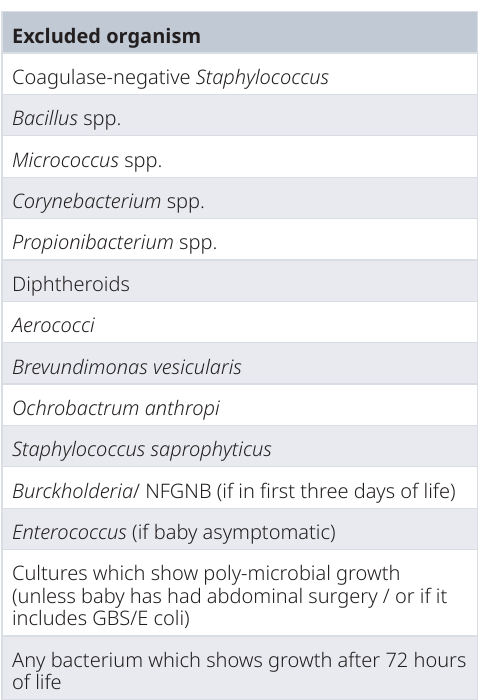
Table 6. Selected organisms considered possible contaminants or skin commensals for neonatal infection (non-exhaustive